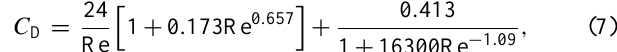
Fig. 9. Velocity of clasts (assumed spherical with density of Figure 9: Velocity of clasts (assumed spherical with density of 2500 kg/m 2500kgm − 3 ) as a function of their diameter for Puianello and function of their diameter for Puianello and Regnano muds. The solid curves are 698 Regnano muds. The solid curves are based on the the empirical based on the the empirical Herschel-­‐Bulkley scaling, equation (5). Numbers next to 699 circles on these curves indicate the Reynolds number. The dashed curves are 700 Herschel-Bulkley scaling, Eq. (5). Numbers next to circles on these equation (7) with viscosity in Re based on our measurements. Inset sows the same 701 curves indicate the Reynolds number. The dashed curves are Eq. (7) curves on linear scales. 702 with viscosity in Re based on our measurements. Inset shows the 703 same curves on linear 704